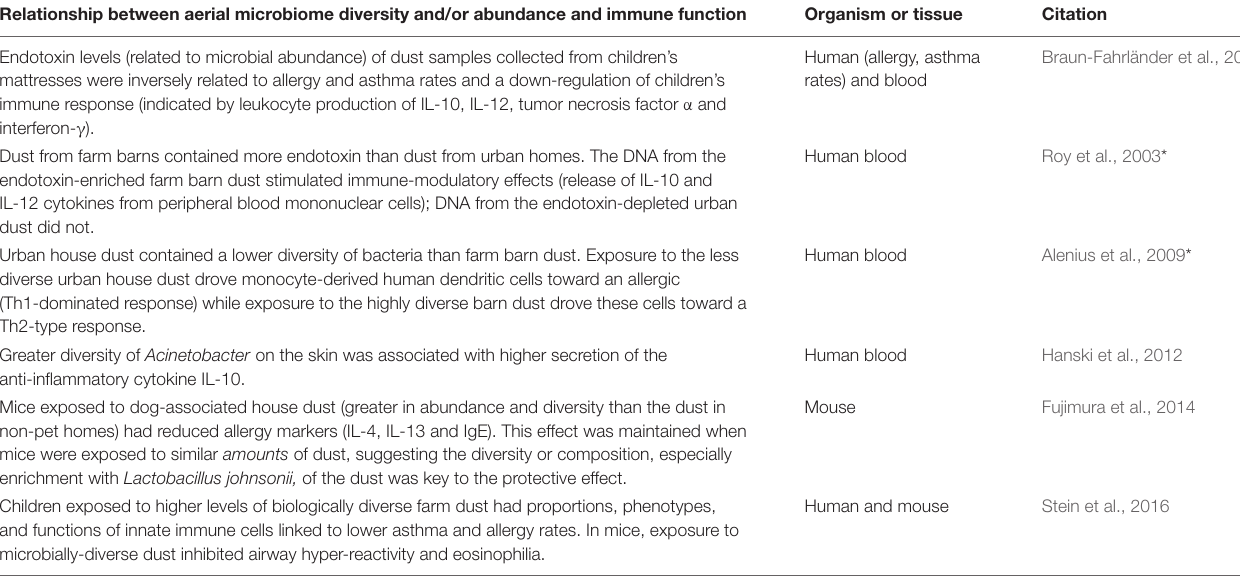
TABLE 1 | Selected experimental studies demonstrating the immunological effect of exposure to diverse aerial microbial communities in mice and humans. Relationship between aerial microbiome diversity and/or abundance and immune function Organism or tissue